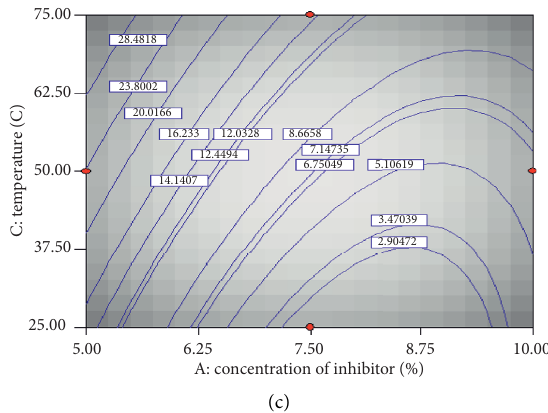
Figure 7: Contour plot of corrosion rate as a purpose of inhibitor load and temperature at the rotational speeds (a) 250rpm, (b) 200rpm, and (c) 150rpm